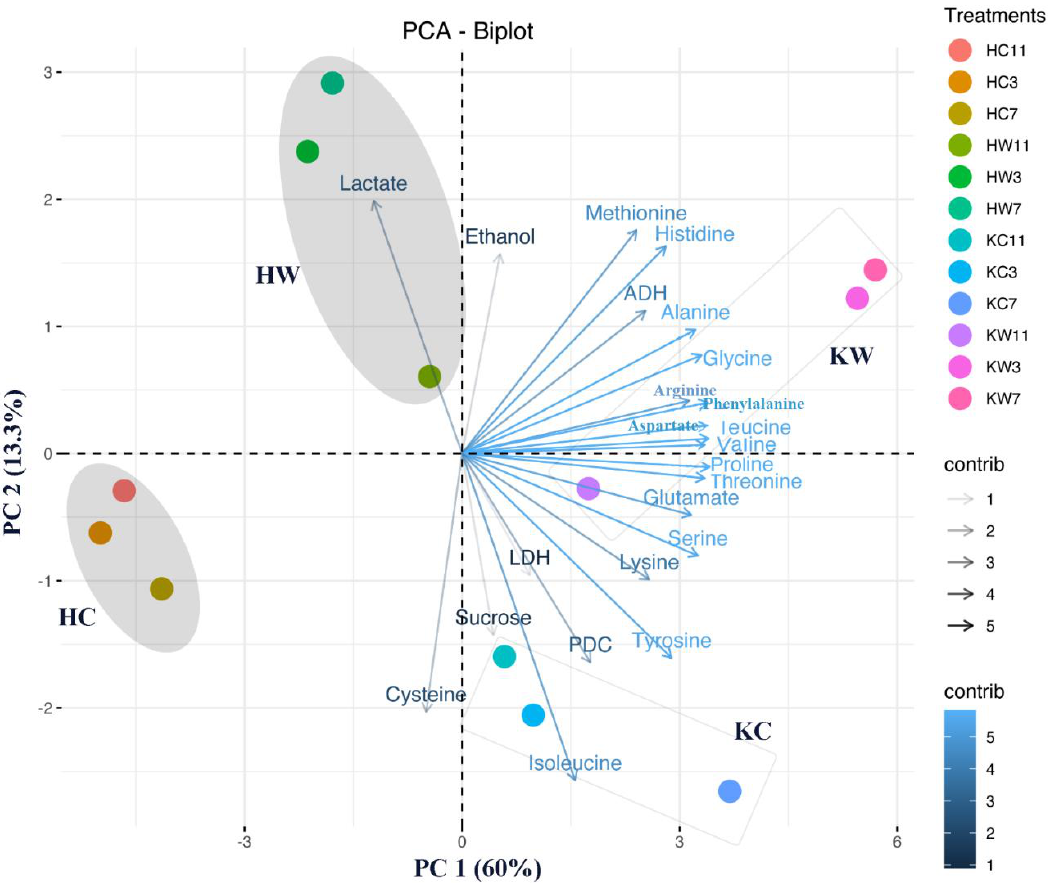
Figure 10. Bi-plot of the first and second principal components of evaluated root traits in ‘Hayward’ and KR5 under control and waterlogging conditions. HC, control of ‘Hayward’; HW, waterlogging of ‘Hayward’; KC, control of KR5; KW, waterlogging of KR5. Data from 3, 7, and 11d of waterlogging treatments and their respective controls are used for the analysis.